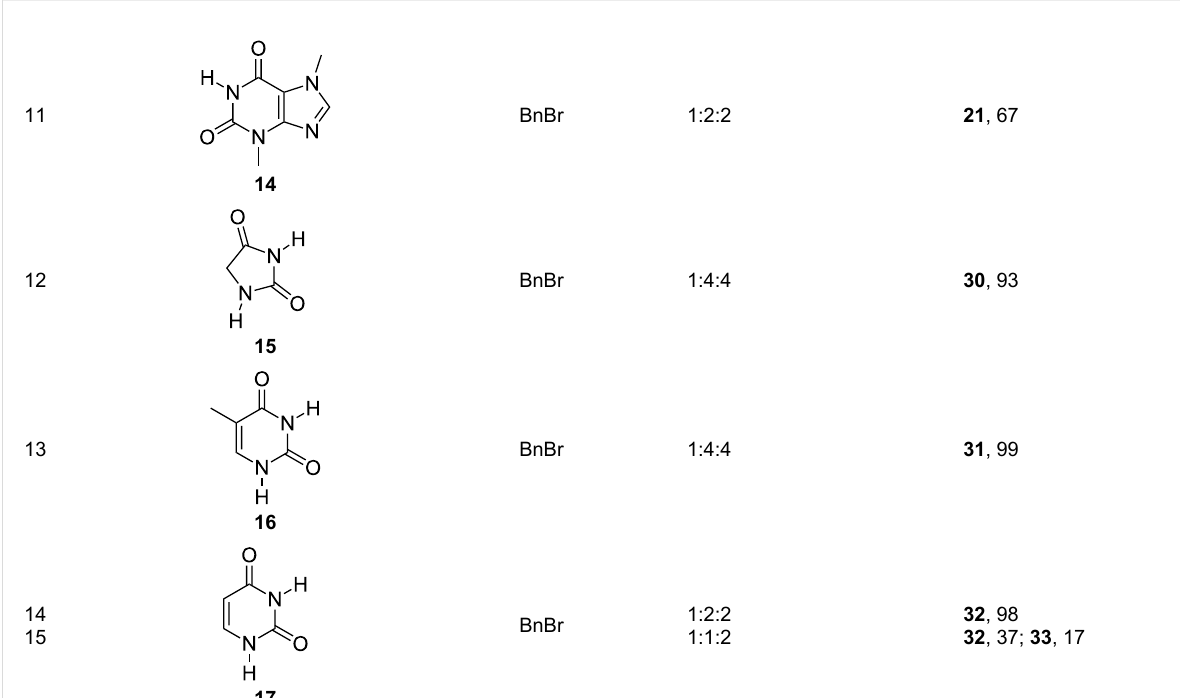
Table 3: Mechanochemical N -alkylation of imides 11–17 . a (continued)